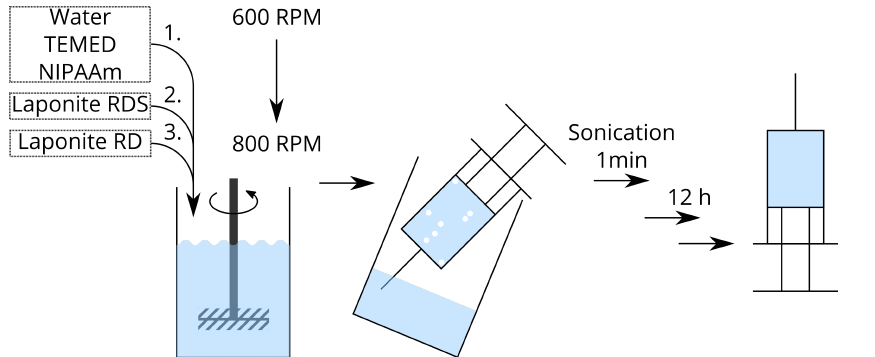
Figure 1. Procedure to prepare the pregel solution.